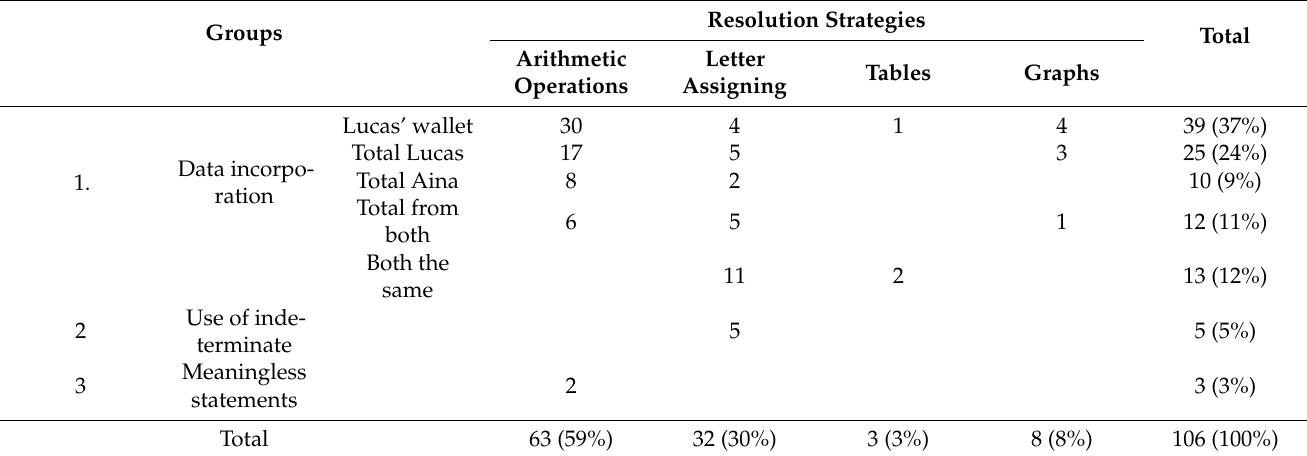
Table 4. Tasks posed and types of resolution in case 2.